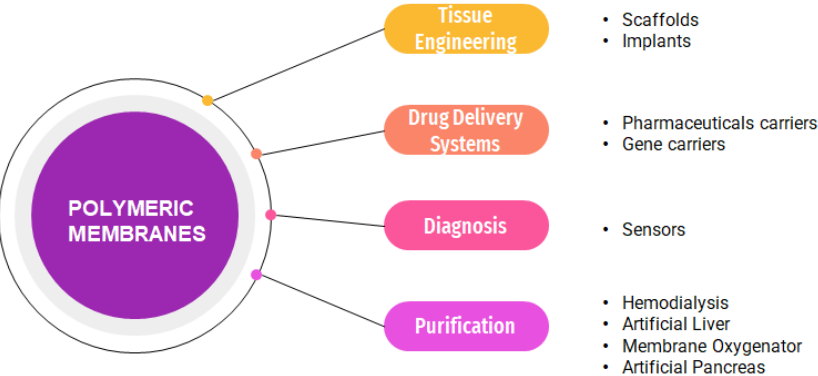
Figure 1. Polymeric membrane applications in the biomedical field.